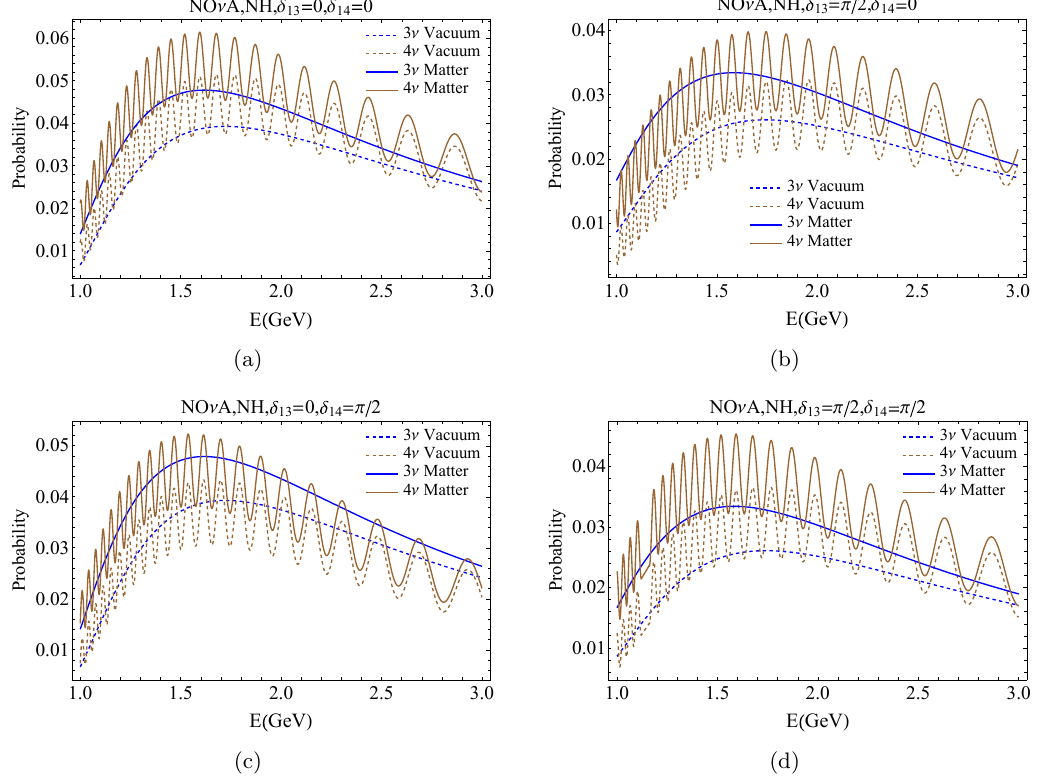
Figure 2 . Netutrino oscillation probabilities for the (cid:23) (cid:22) ! (cid:23) e channel as a function of energy E for various dirac CP phase (cid:14) 13 ; (cid:14) 14 in NO (cid:23) A experiment. The blue (brown) curves denote the 3 (cid:23) (4 (cid:23) ) cases, while the solid (dashed) curves correspond to the matter (vacuum)